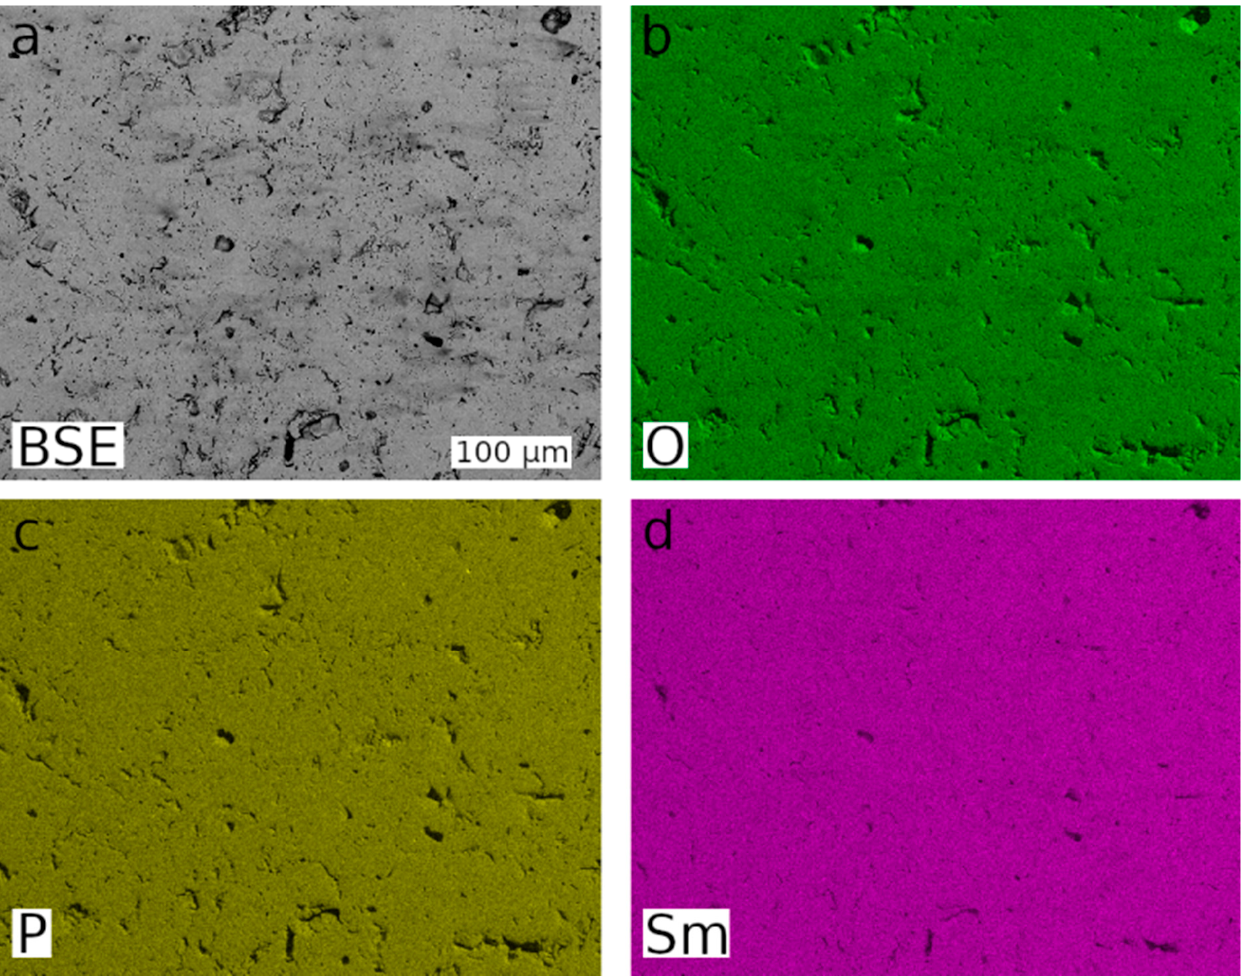
Figure 3. SEM-BSE image ( a ) and results of EDS elemental mapping of the distribution of oxygen ( b ), phosphorous ( c ), and samarium ( d ) performed on a polished SmPO 4